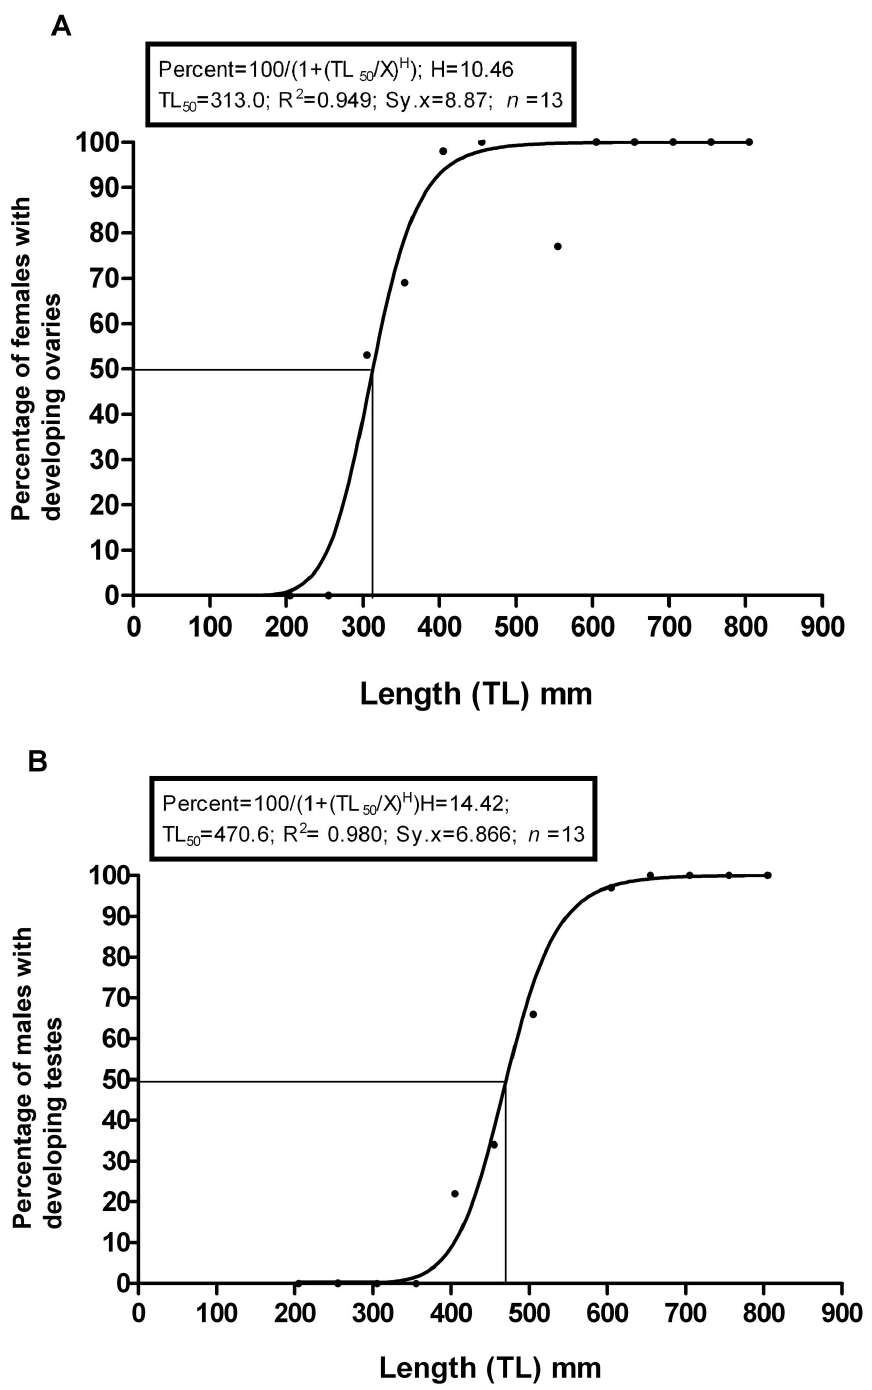
Figure 14. The initiation of female and male gonadal development. (a) The percentage of female hagfish with developing ovaries as a function of TL. The assumptions made are (1) that before male gonadal development has been initiated, and sex cannot be determined macroscopically (Stage 0), the genetic sex ratio is 1:1, and (2) the genetic sex ratio within each 50 mm TL intervals remains 1:1 throughout, although the individuals in a given interval may or may not have initiated gonadal development. (b) The percentage of male hagfish with developing testes as a function of TL. This graph is based on the same assumptions as part (a). Males begin gonadal development at a larger TL than females, and males at Stage 0 persist at TLs where all females have initiated ovarian development. doi: 10.1371/journal.pone.0078740.g014 PLOS ONE |